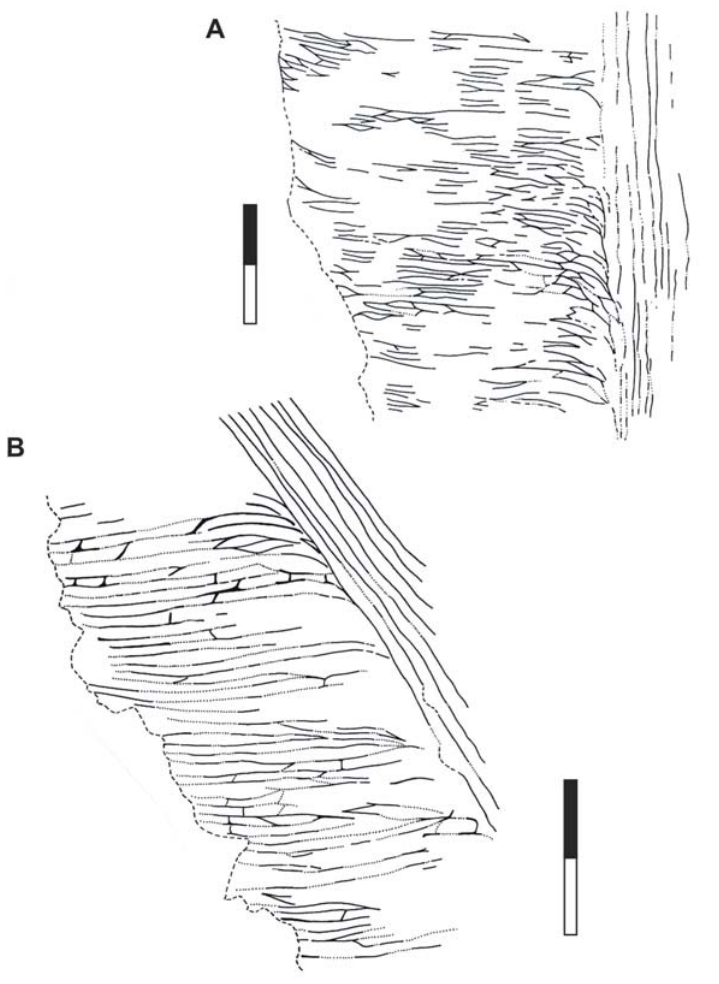
Fig. 1 – Drawings of described Glossopteris leaves: (A) specimens of Glossopteris cf. G. occidentalis White [MP-Pb 3576A] and (B) Glossopteris sp. 1 [MP-Pb 3577A] showing a middle portion of the leaf with prominent and thick midrib and taeniopteroid venation, respectively. Continuous line = outline preserved; dotted line = outline poorly